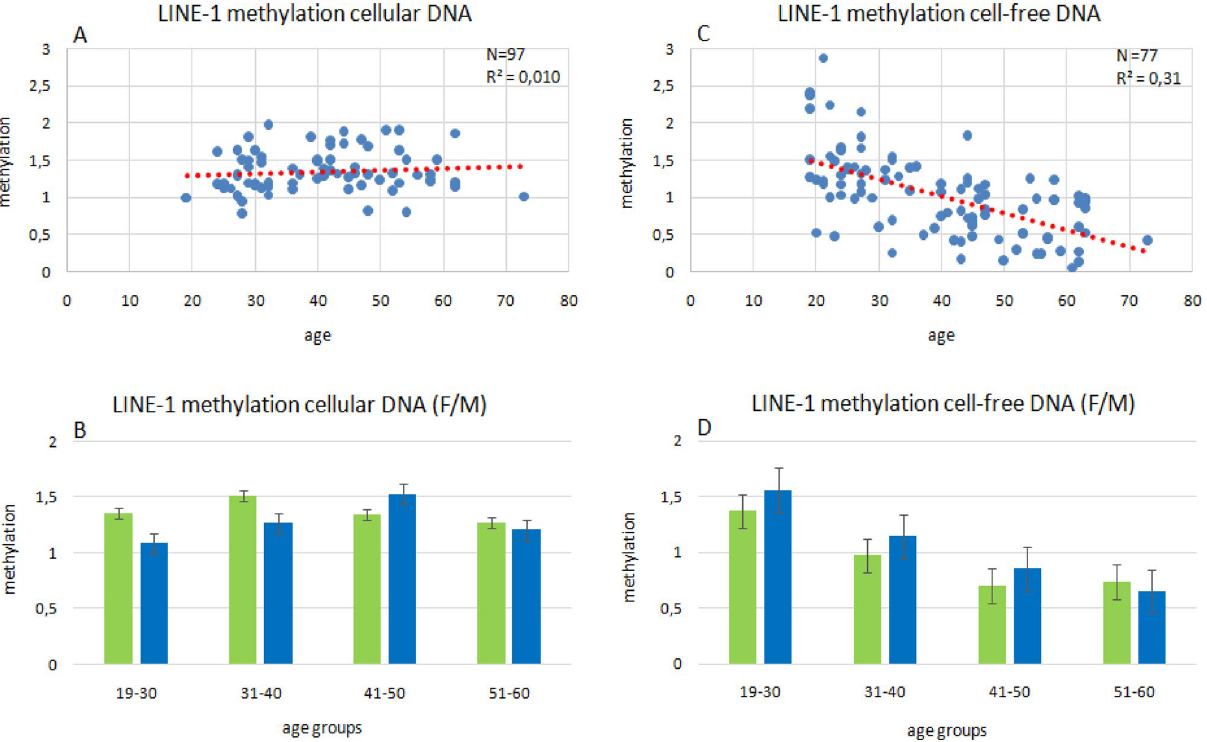
Figure 1. Relative quantification of age-dependent LINE-1 methylation by IDLN-MSP in cellular and cfDNA. Correlation between age and DNA methylation of LINE-1 promoter region in cellular DNA ( A , B ) and cell- free DNA ( C , D ) derived from blood plasma of the indicated numbers of donors (N). The regression lines are colored in red and represent Pearson’s correlation coefficients (R 2 ). Mean values of global DNA methylation at LINE-1 retrotransposons in cellular DNA and cell-free DNA from blood plasma by age subgroups ( B , D ). Mean values were compared by two-sample Student’s t-test with a significance threshold p < 0.05. 19–30 to 31–40 years, p = 0.01, 19–30 to 41–50 years, p = 0.0000043026, 19–30 to 51–60 years, p = 0.0000000049, 31–40 to 41–50 years, p = 0.1897896039, 31–40 to 51–60 years, p = 0.0040846031,